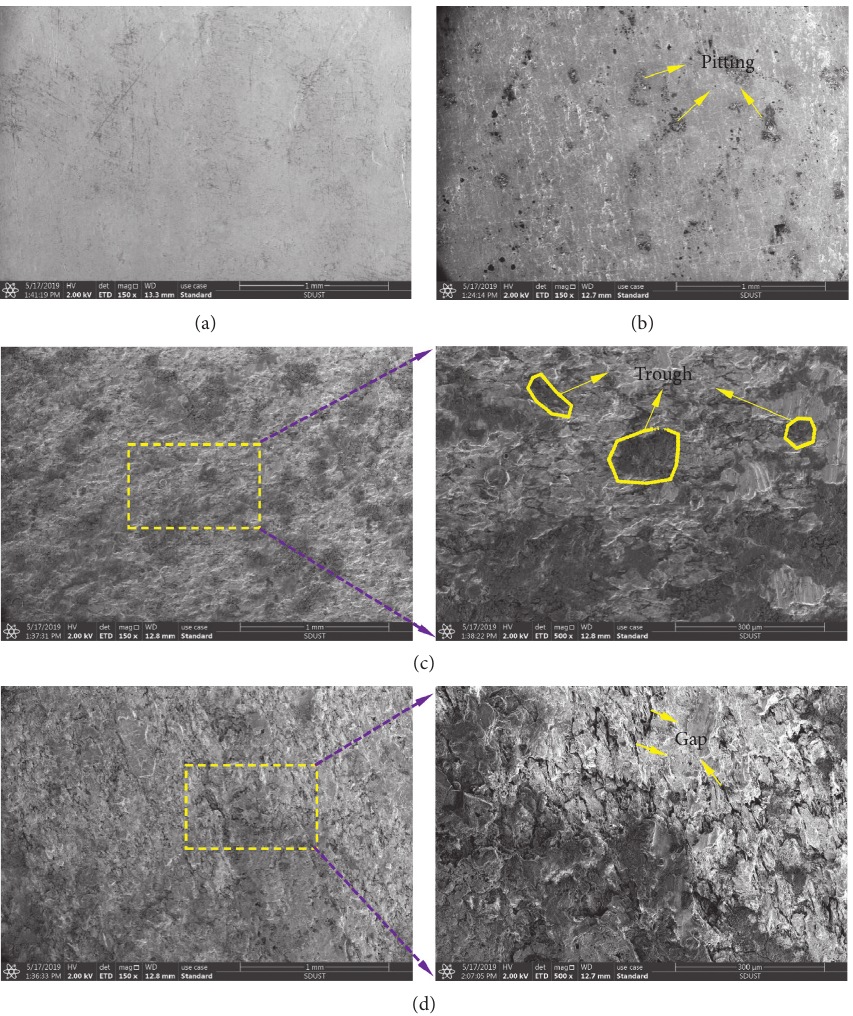
Figure 7: SEM images of the outside surface of pipe specimen: (a) uncorroded pipe; (b) pipe with corrosion rate of 9.62%; (c) pipe with corrosion rate of 31.57% (left: 150 times; right: 500 times); (d) pipe with corrosion rate of 68.71% (left: 150 times; right: 500